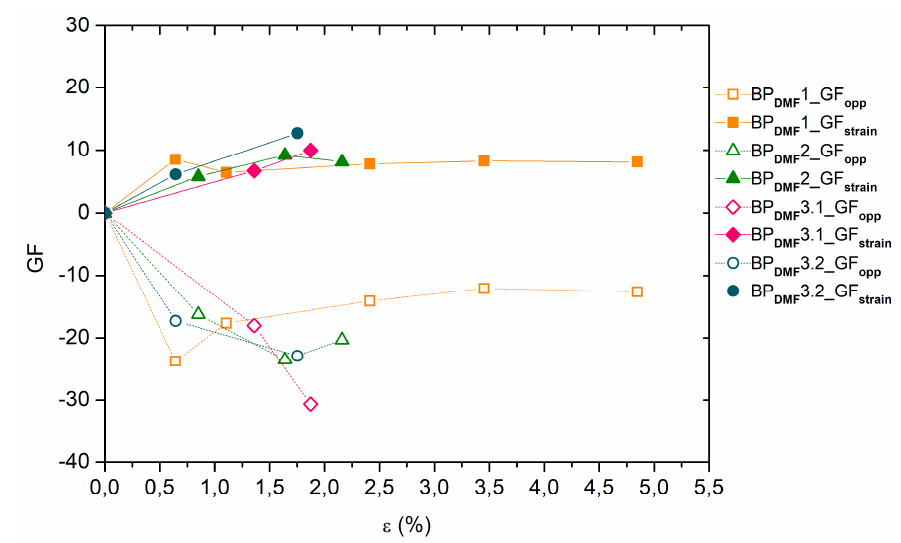
Figure 6. Gauge factor (GF) versus strain ε for the BP DMF / PI samples (GF strain and GF opp values in axial strain and opposite (transverse) directions, respectively). Table 1. Summary of the sensitivity, electrical properties, and deformation at break ( ε b ) of the BP and knocked-down VA-CNT-based sensors in the axial (strain) and transverse directions.